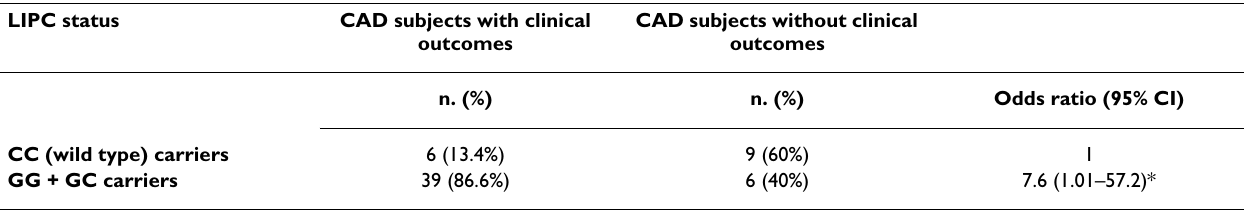
Table 4: Relative risk of clinical outcomes (a second PTCA, myocardial infarction, CABG, cardiovascular death) according to LIPC gene